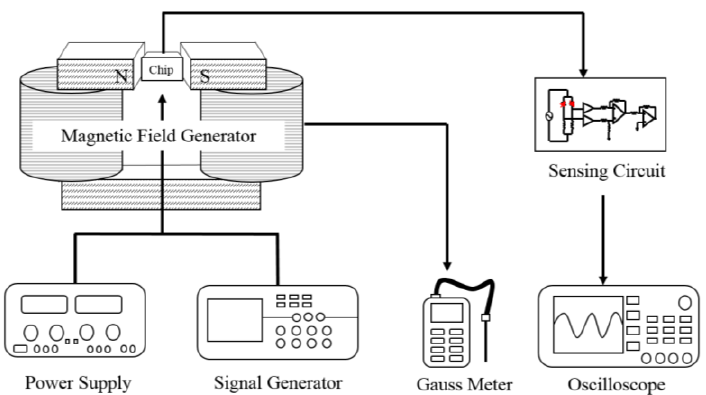
Figure 10. Measurement set-up of the magnetic